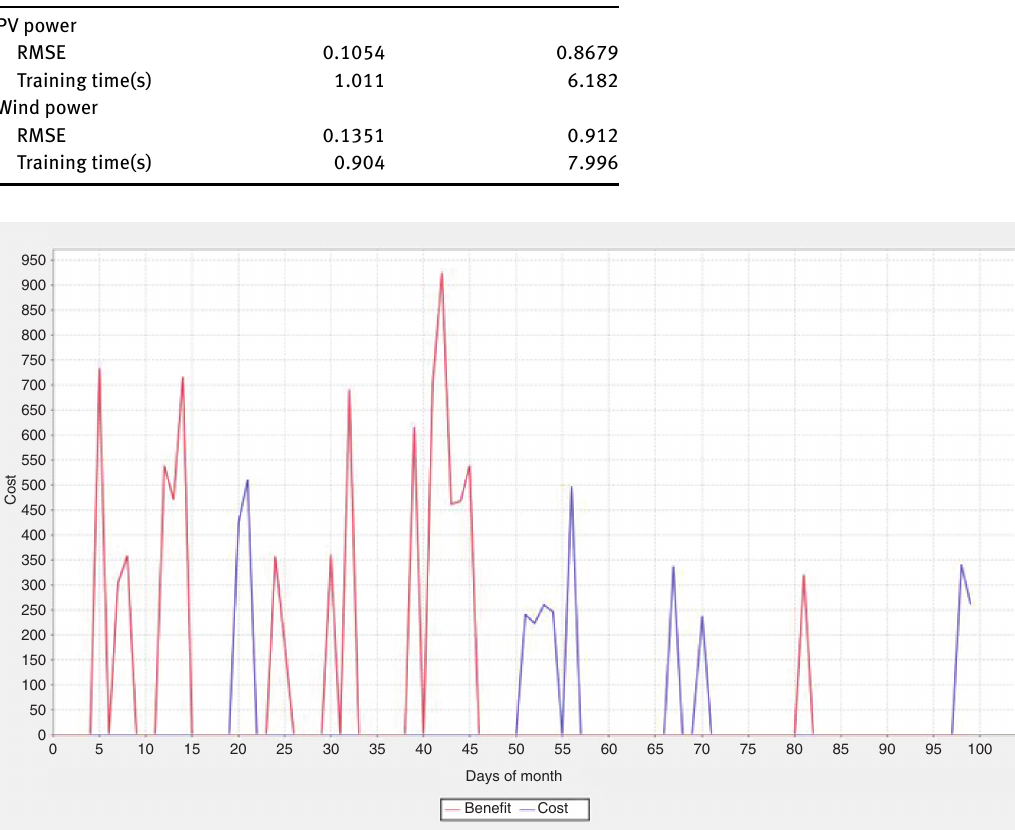
Table 3: Skill Metric in Terms of the Overall RMSE and Training Time. Skill metric ELM BP